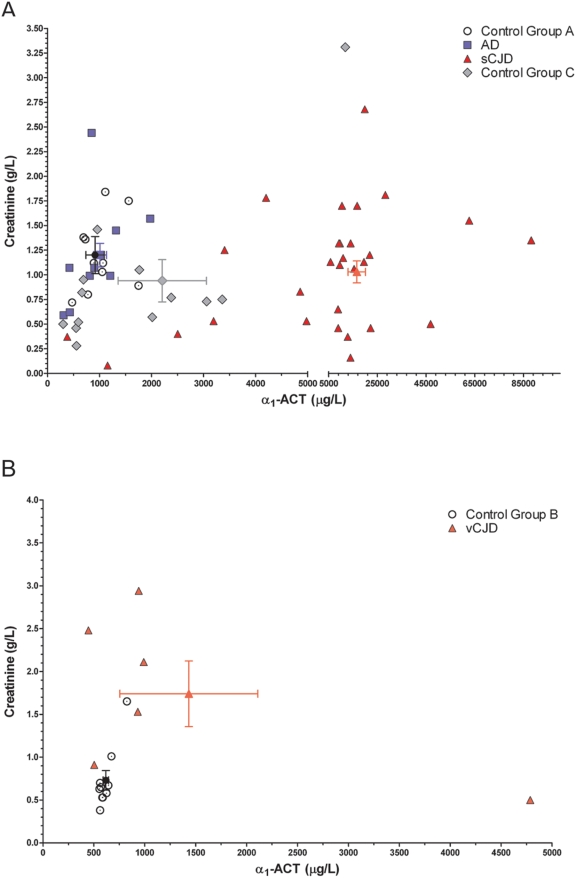
Urinary α1-ACT and creatinine levels.α1-ACT levels (µg/L) were plotted relative to creatinine levels (g/L) for (a) sCJD patients together with Control group A, AD, and Control group C patients and (b) vCJD patients together with respective Control group B patients. Error bars represent s.e.m.